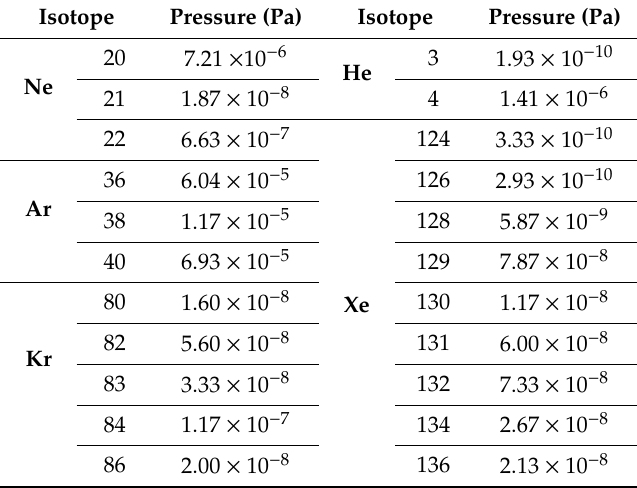
Table 6. Equilibrated partial pressures p m of noble gases isotopes during static